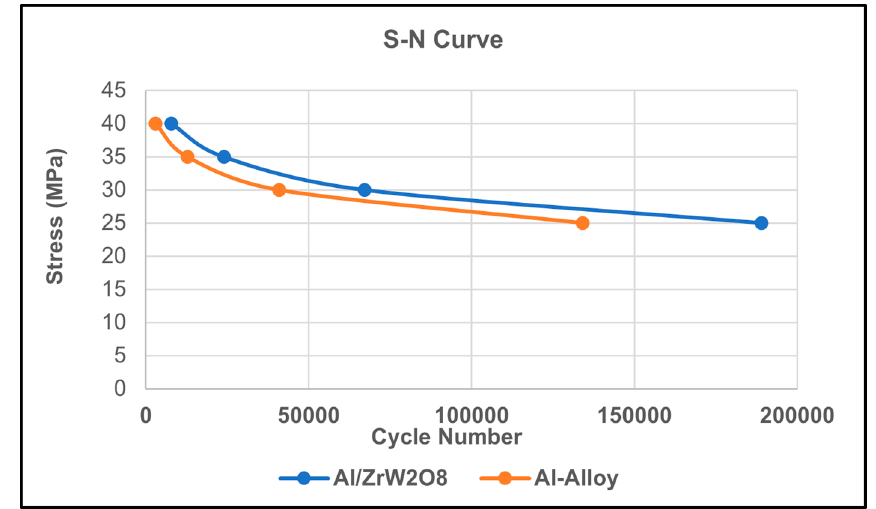
Figure 11. Stress amplitude and fatigue life comparison of base aluminum alloy and Al/ZrW 2 O 8.